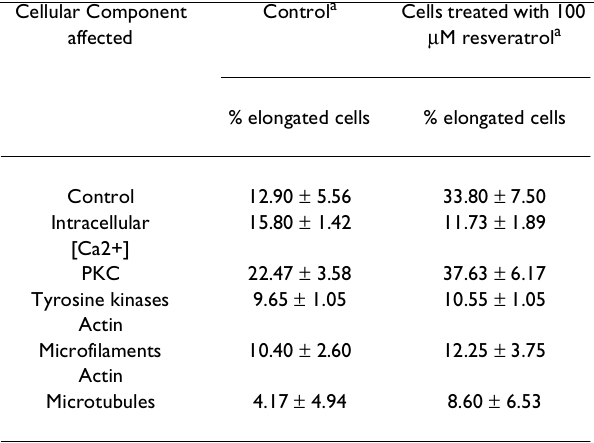
Table 1: Use of inhibitors to probe the basis for elongation of BPAEC induced by resveratrol. These experiments used passages 4-5 BPAEC cells. The cells on cover slips were incubated with in- hibitors for 24 h, before 100 µ M resveratrol was added and incu- bation was continued for an additional 40 h. An exception was quin2-AM, which was applied 1 h prior to resveratrol treatment. Cellular Component